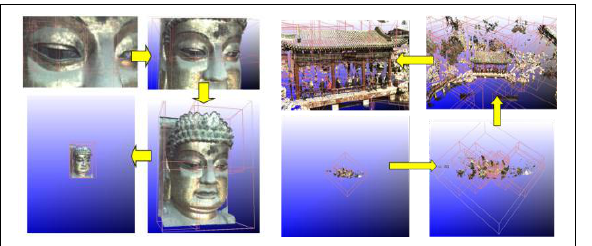
Figure 5 LOD display of point image (Left: Buddha’s head) and point image model (Right: Beihai Park) The red wireframe represents the MBB property of node data.